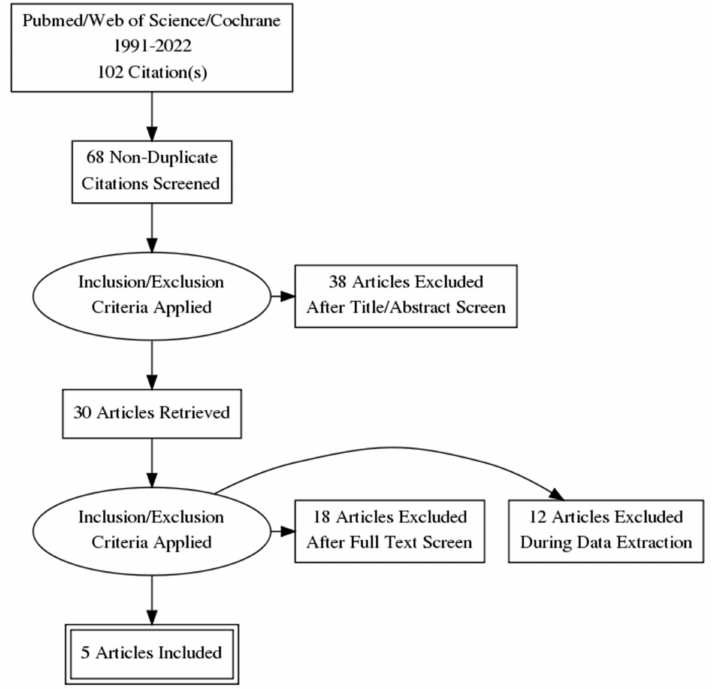
Figure 1. Screening and selection process—PRISMA